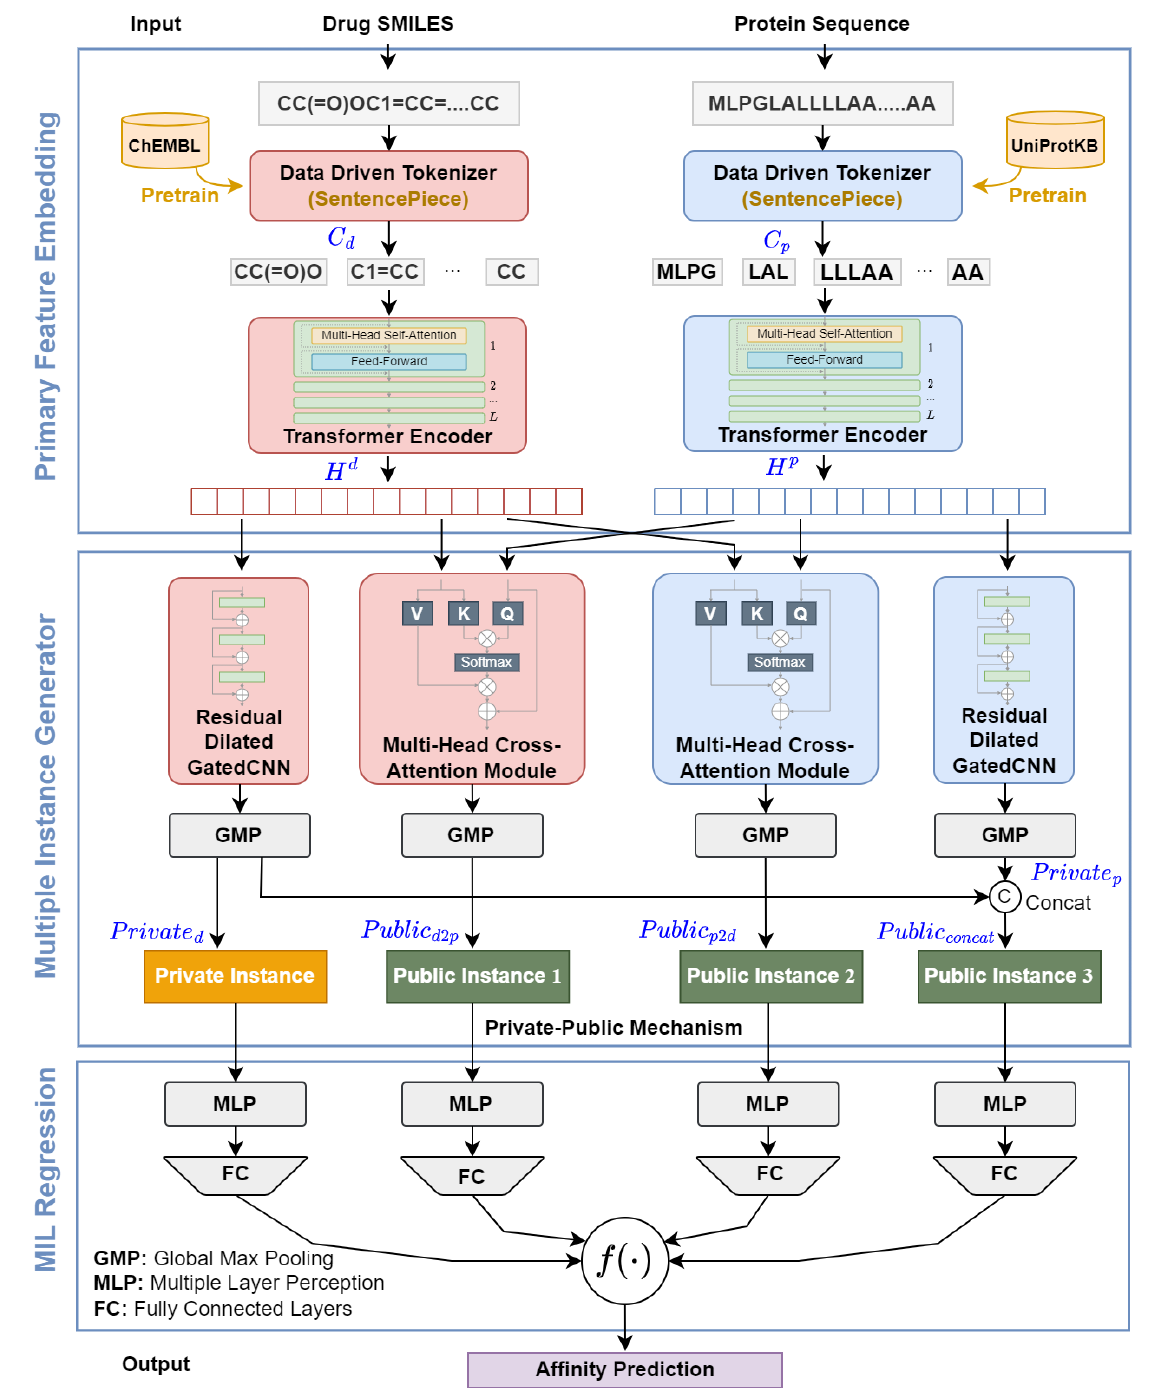
Figure 2. A graphical illustration of